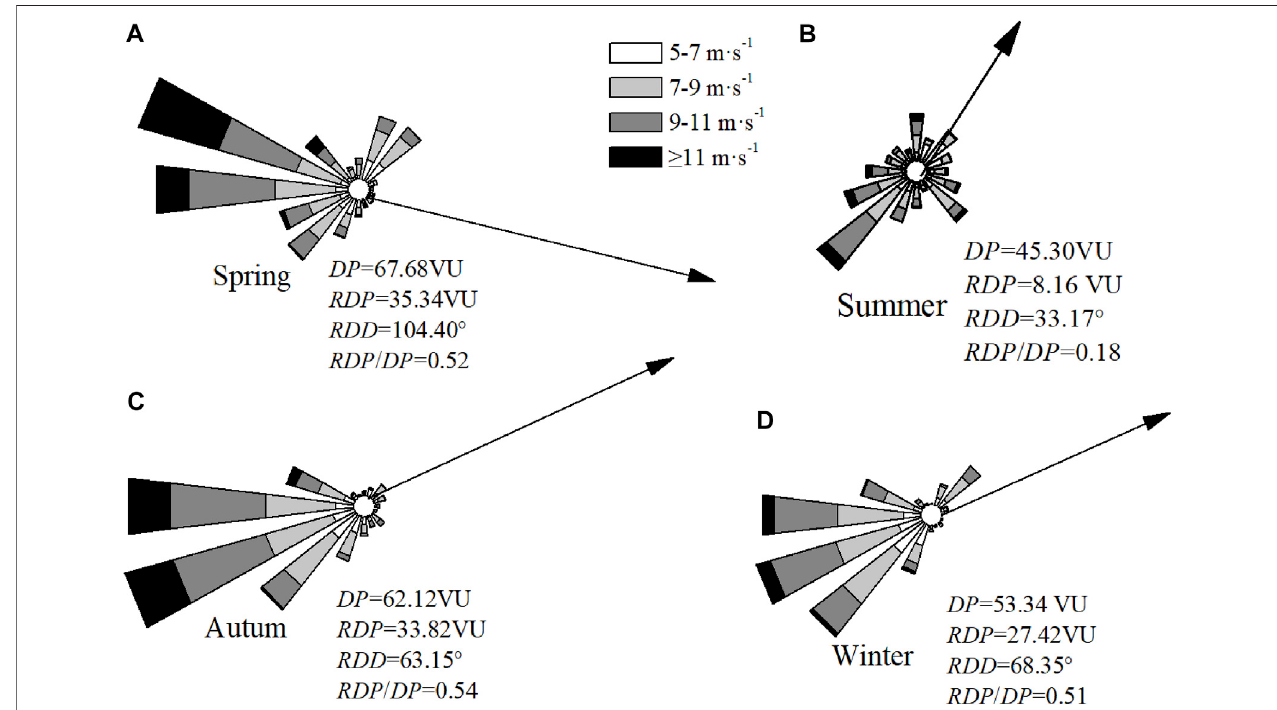
FIGURE 7 | Drift potential in the desert in (A) spring, (B) summer, (C) autumn, and (D) winter. The calculated resultant drift potential (RDP) and resultant drift direction (RDD) are shown in black arrow.